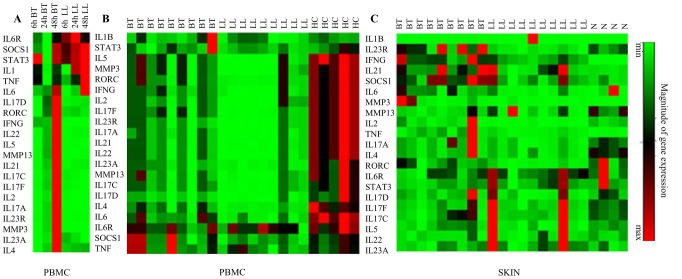
cDNA microarray heat map showing magnitude of expression.Fluoresce intensity of gene products determined by real time quantitative PCR (qPCR) with SYBER green as reporter. Selected cytokines, chemokines and transcription factors related to Th17 pathway and Th1 and Th2 cytokines are listed on the left side. Each horizontal row represents the same gene product and each vertical row each patient. The fluorescence range from high (red) to low (green) is indicated by the colored bar and reflects the degree of fluorescence intensity/gene expression. A. Shows time related gene expression at 6, 24 and 48 hrs of antigen stimulated PBMC in 3 each of borderline tuberculoid (BT) and polar lepromatous leprosy (LL) as described in Materials and Methods. B. Gene expression in 48 hr stimulated PBMC of 9 BT and 9 LL patients and 5 healthy contacts/controls (HC) exposed to long term infection showing the increased expression in HC followed by BT as compared to LL for the Th17 related genes. C. Skin lesions in general showed variability in some genes also show similar increased gene expression in HC, BT as compared to LL.